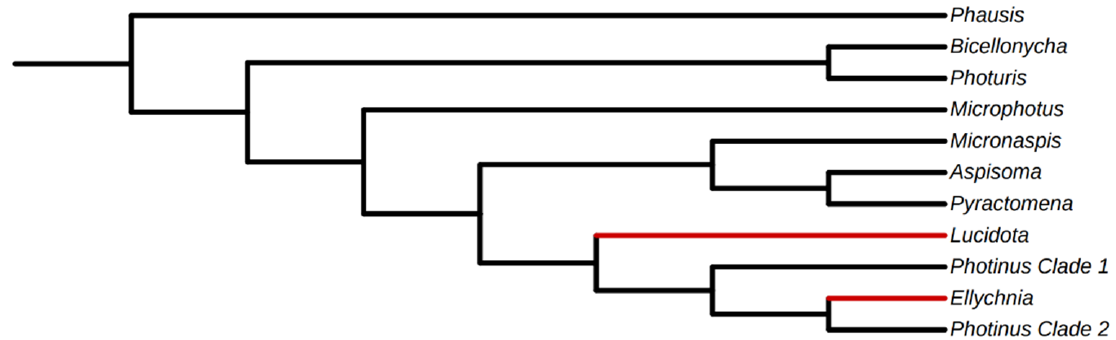
Figure 2. Cladogram showing generic relationships of sampled taxa. Relationships modified from [29,38]. Taxa in red indicate diurnal lineages.